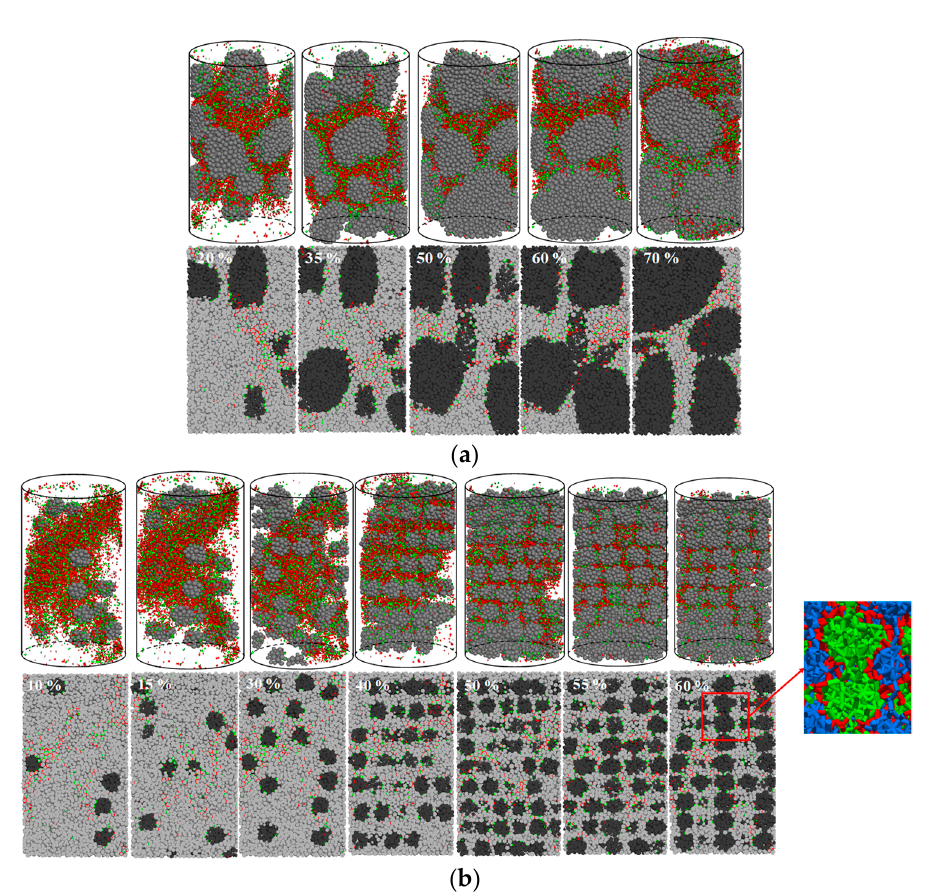
Figure 8. Distribution of cracks with different gravel content. ( a ) Fracture distribution of irregular gravel with different content; ( b ) Fracture distribution of spherical gravel with different content.